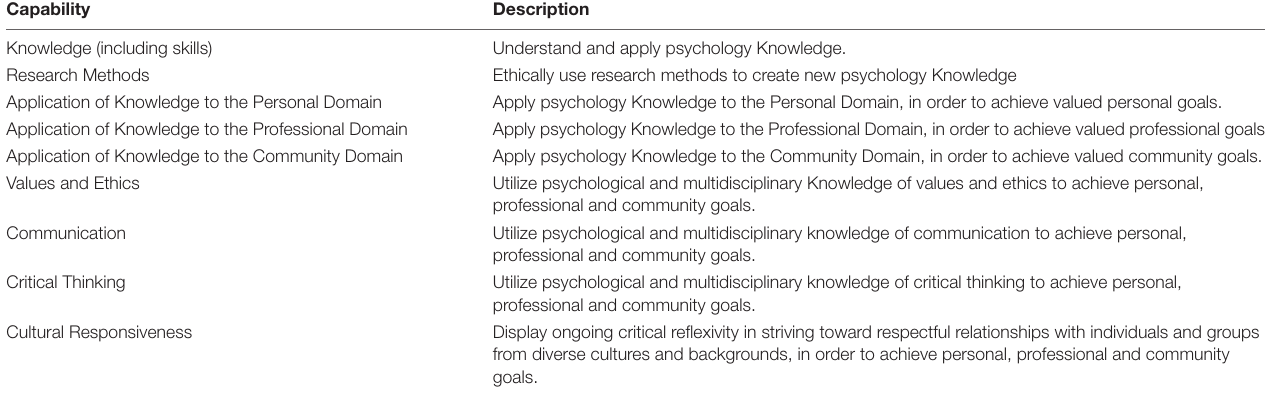
TABLE 1 | Undergraduate psychology